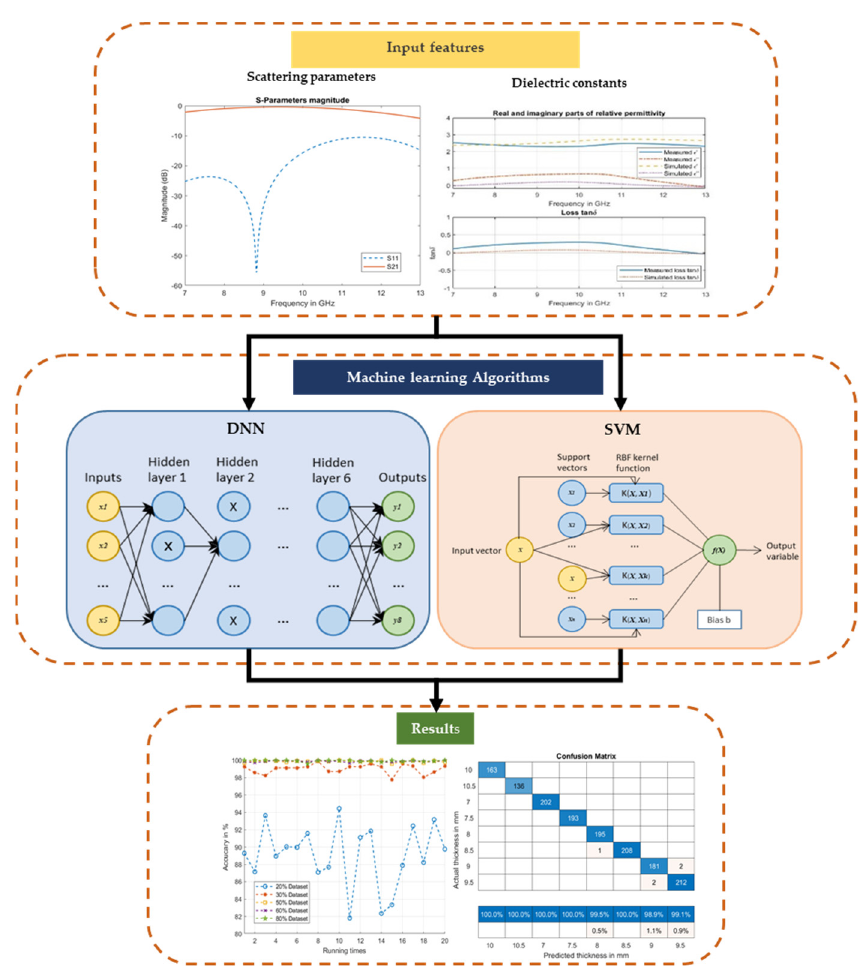
Figure 7. The investigational platform.